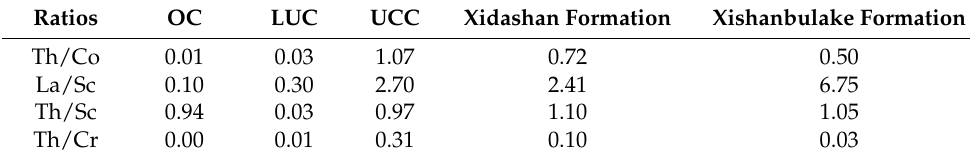
Table 4. Characteristic trace element content ratio of Lower Cambrian mudstone.